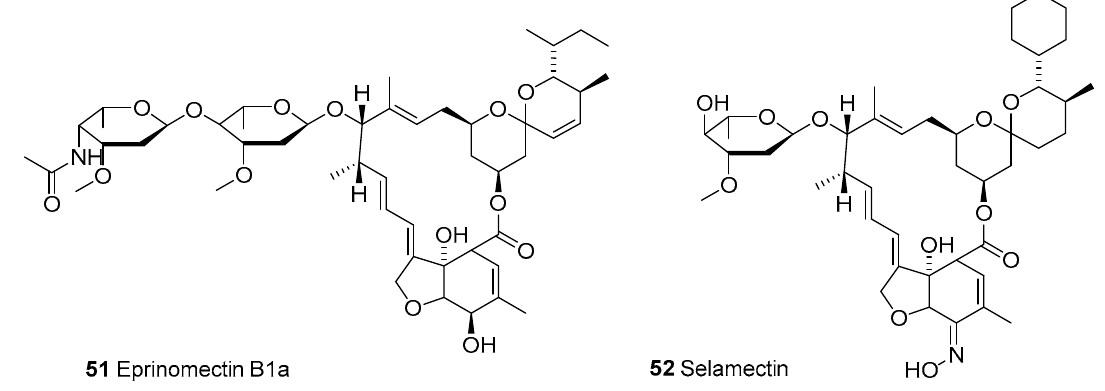
Figure 16. Macrolactone endectocides [97].